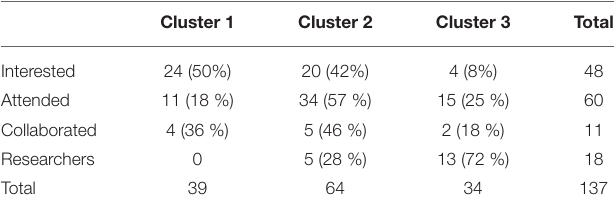
TABLE 3 | Results of clustering participants by their answers in the neuromyth